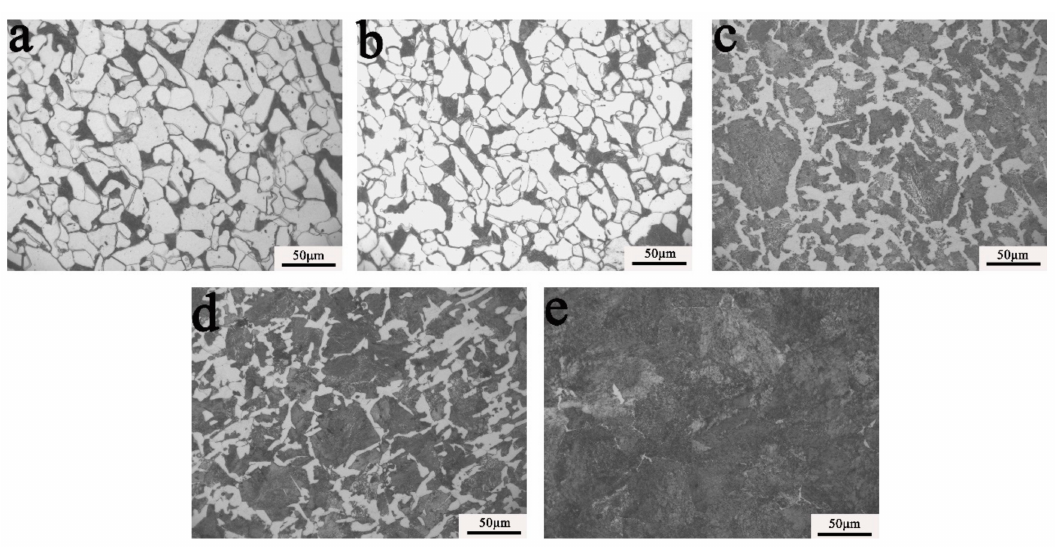
Figure 6. The microstructure of base material samples: ( a ) A1, ( b ) A2, ( c ) A3, ( d ) A4, and ( e ) A5.